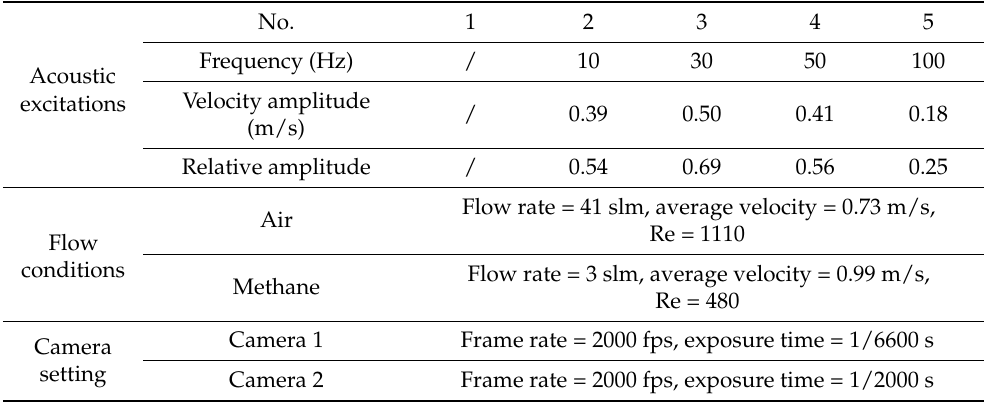
Table 1. The test conditions and parameters of experiment setup.